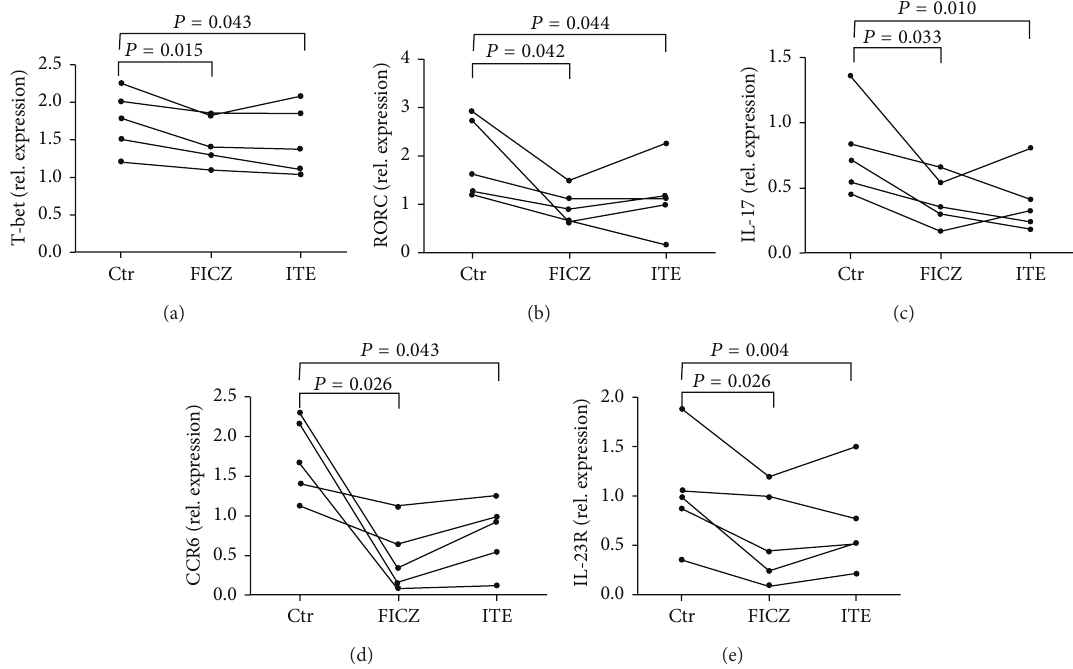
Figure 6: FICZ and ITE inhibit the molecules associated with Th1 and Th17 cell effector function in stimulated CD4 + T cells. CD4 + T cells from healthy controls ( 𝑛 = 5 ) were cultured with anti-CD3/CD28 and rIL-23 in the presence or absence of FICZ or ITE for 6 days. The cells were harvested for mRNA analysis of T-bet, RORC, IL-17, IL-23R, and CCR6 expression by real-time PCR. Paired-sample t test for related samples was used for statistical